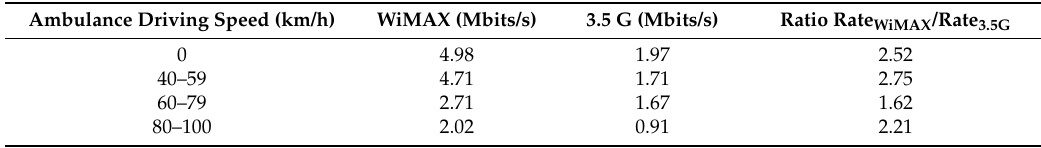
Table 1. Transmission data rates of WiMAX and 3.5 G networks at various driving speeds.